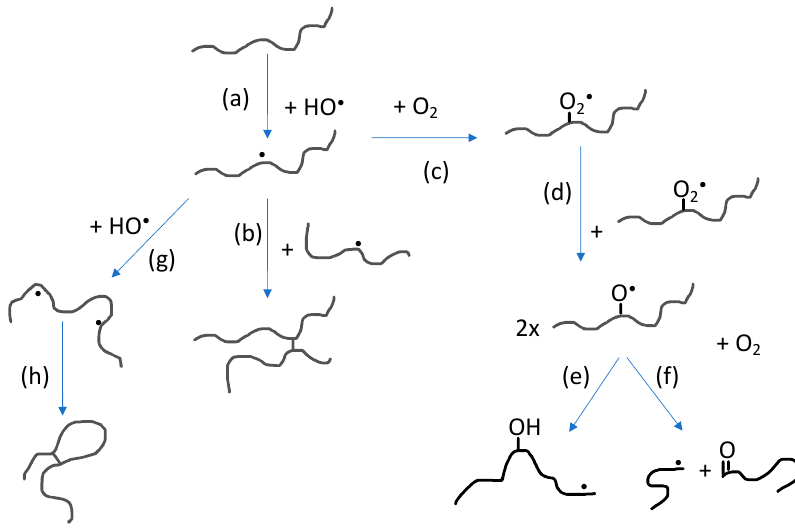
Figure 3. Reactions involving polymer radicals in aqueous solution: ( a ) Hydrogen abstraction by hydroxyl radicals producing polymer radicals; ( b ) intermolecular radical combination (the competing disproportionation is not shown); ( c ) reaction with molecular oxygen; ( d ) reaction between peroxyl radicals; ( e ) intramolecular H-transfer; ( f ) oxyl radical β -scission; ( g ) hydrogen abstraction from polymer radical producing multiple radical sites; and ( h ) intramolecular radical combination (also in this case, disproportionation is not shown).